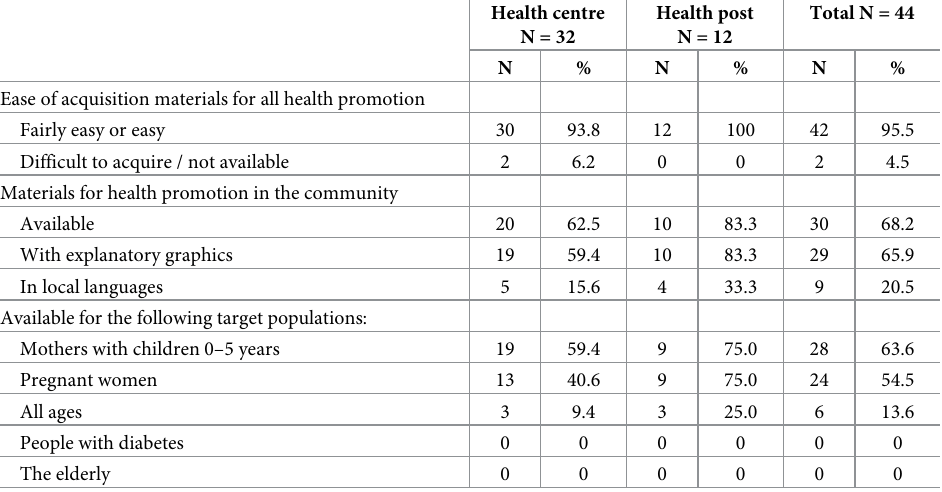
Table 4. Materials for health promotion and target